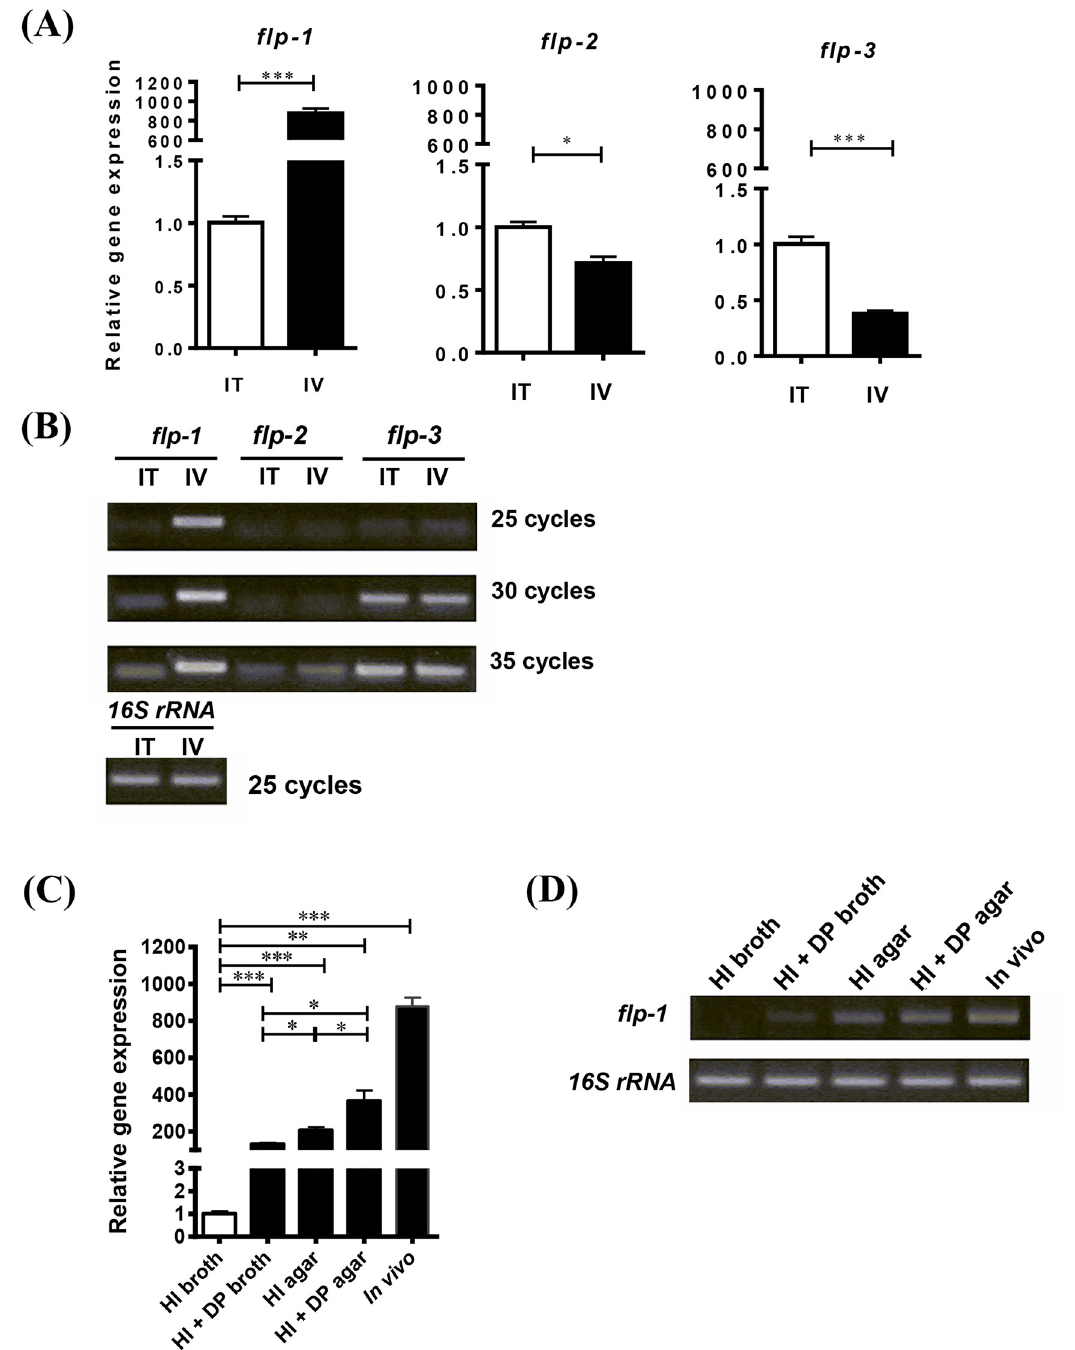
Fig 1. Transcriptional analyses of structural flp genes in three tad operons of V . vulnificus . RNA was isolated from bacteria grown in the rat peritoneal cavity (IV, in vivo ) or in 2.5% NaCl HI broth (IT, in vitro ) and the transcript levels of the structural flp genes were analyzed via real-time (A) and conventional RT-PCR (B) . RNA was isolated from bacteria grown under 2.5% NaCl HI broth, iron-limited, solid surface and in vivo conditions and the transcript levels of the structural flp genes were analyzed via real- time (C) and conventional RT-PCR (D) . DP (80 μ M) was added to 2.5% NaCl HI broth for iron limitation. The real-time RT-PCR data were normalized to gyrA and expression relative to the in vitro level. Data shown represent the mean ± SEM of three independent experiments performed in triplicate. Statistical analysis was carried out using Student’s t test ( � , P < 0.05; ��� , P <